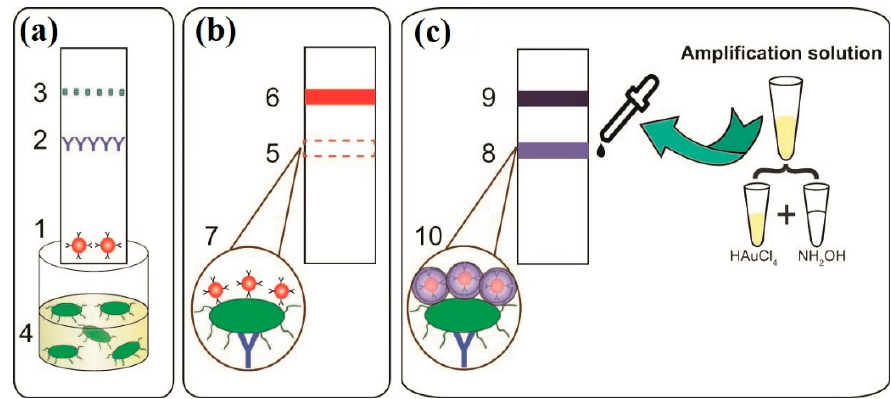
Figure 1. Lateral flow immunoassay (LFIA) scheme before and after signal amplification: ( a ) test strip dipped into a sample of potato tuber extract; ( b ) test strip after conventional LFIA, indicating a negative result because no color band exists in the test zone; ( c ) addition of amplification solution to the test strip and enlargement of the gold nanoparticle (GNP) size. The numbers in the figure indicate (1) GNP–antibody conjugate on the conjugate pad, (2) antibody specific to R. solanacearum immobilized in the test zone, (3) protein A immobilized on the control zone, (4) potato tuber extract containing R. solanacearum , (5) no visible color band in the test zone after analysis, (6) a clear red color band in the control zone, (7) formed immune complex (immobilized specific antibodies, R. solanacearum , GNP conjugate with specific antibody) after conventional LFIA, (8) test zone after signal amplification, (9) control zone after signal amplification, and (10) enlarged GNP particle size caused by the addition of amplification solution.